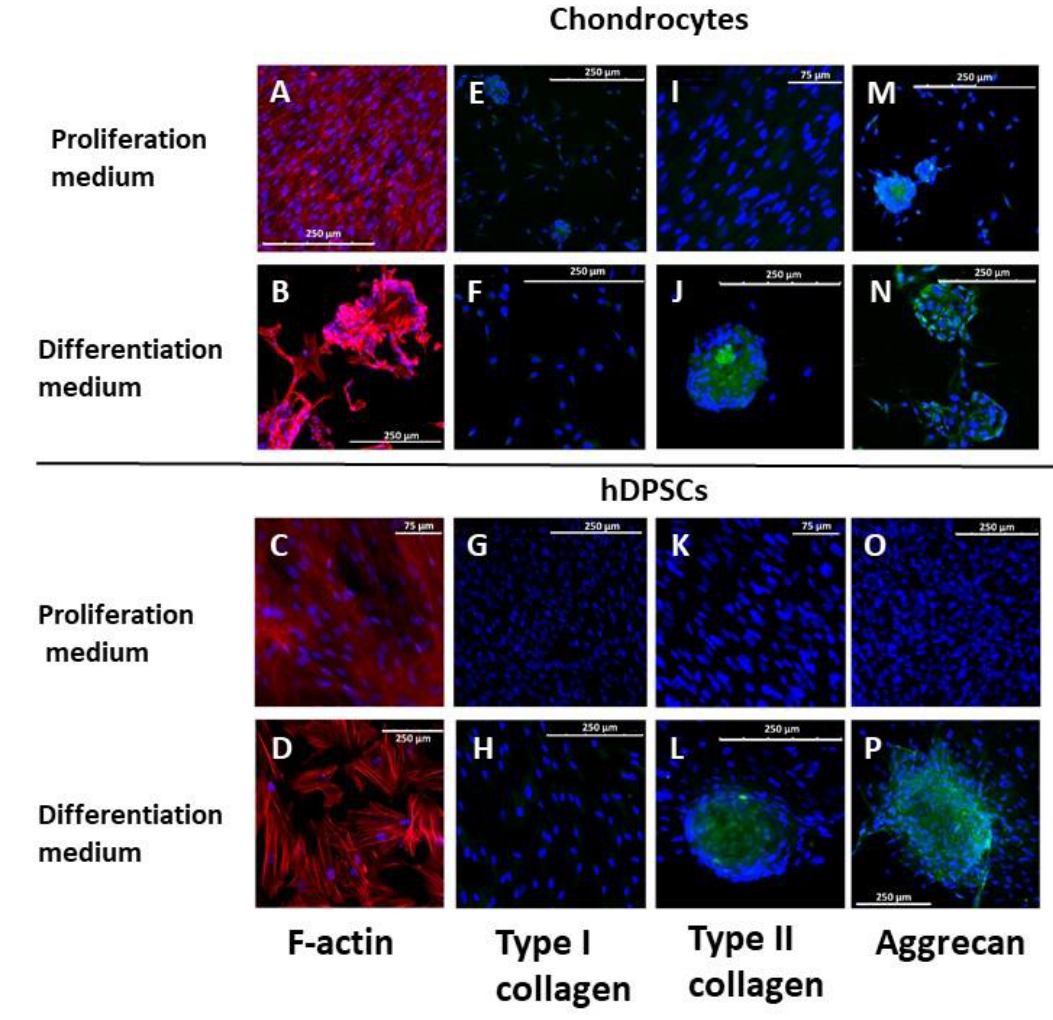
Figure 2. 2-D cultures of human primary chondrocytes (upper panels) and hDPSCs (lower panels). Cells were cultured with proliferation or differentiation medium for up to 4 weeks. F-actin organization was evaluated by fluorescence microscopy using rhodamine-phalloidine ( A – D ). Type I ( E – H ) and II ( I – L ) collagen, as well as aggrecan ( M – P ) were evaluated by immunofluorescence. Nuclei were staining with DAPI. The images are representative of n = 5 different experiments.